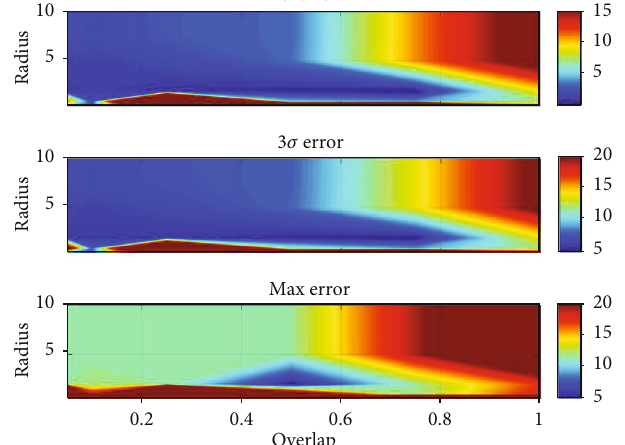
Figure 5: Trade-o ff of number of neurons, radius, and overlap for GRBF-NN trained with the “ original ”